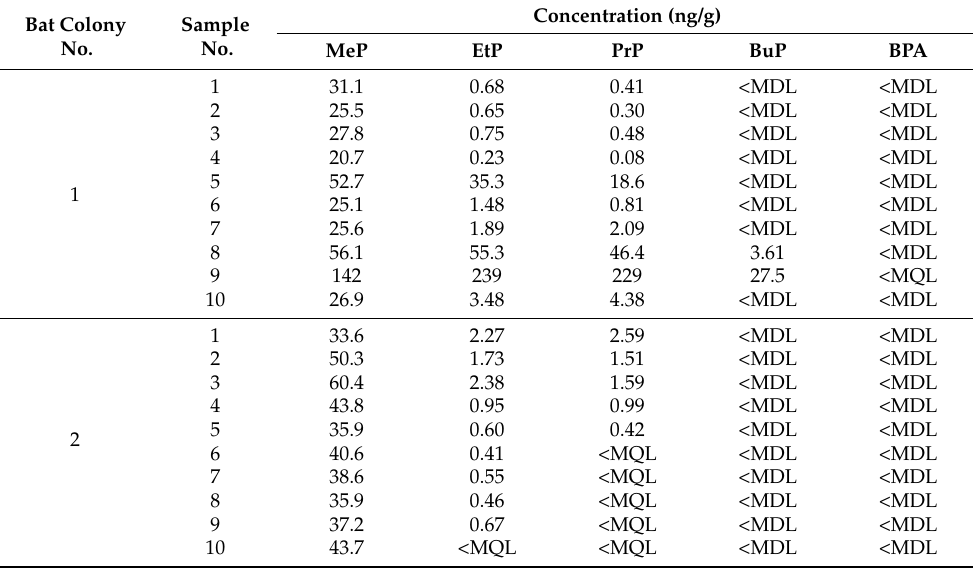
Table 2. Concentration levels (ng/g dw) of parabens and bisphenol A in bat guano samples. Bat Colony